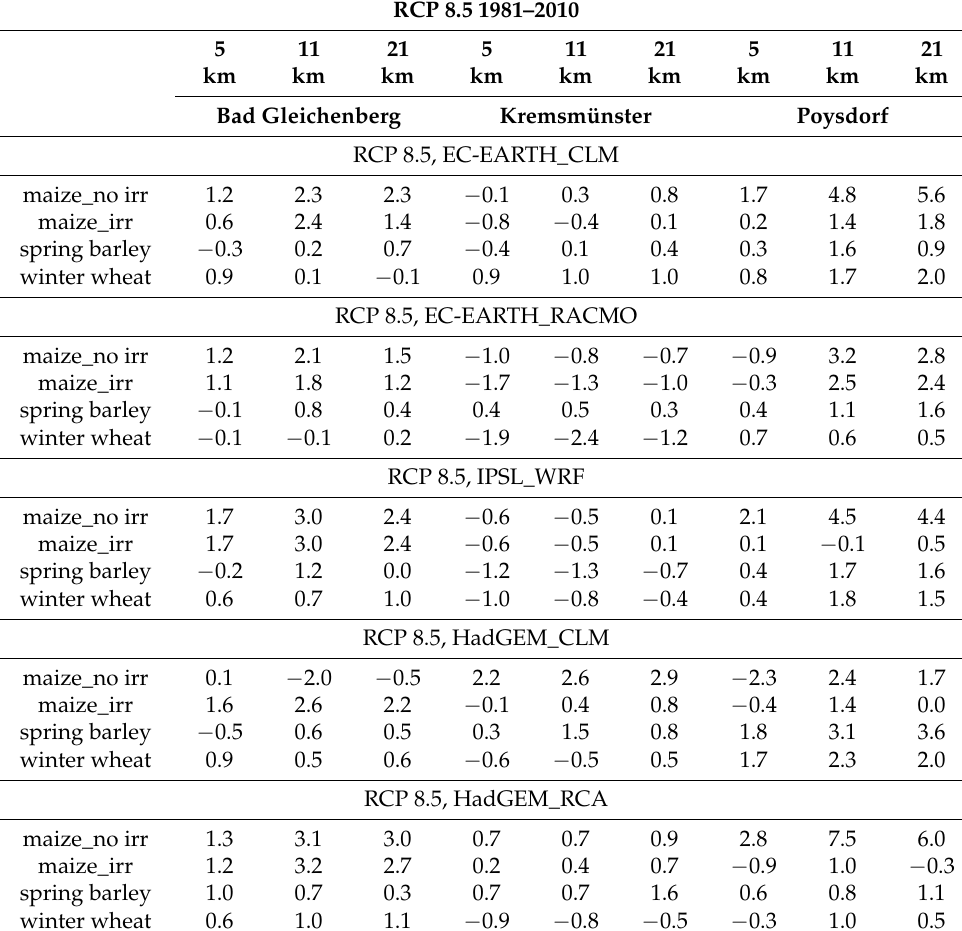
Table 8. Yield differences (%) for maize (rainfed = no irr, optimally irrigated = irr), winter wheat, and spring barley (rainfed) grown on the sandy soil class 1; 1 km input data vs. 5, 11 and 21 km aggre- gated data for five ÖKS15 projections in RCP 8.5 (EC-Earth_CLM, EC-Earth_RACMO, IPSL_WRF, IPSL_RCA and HadGEM_RCA) in Bad Gleichenberg, Kremsmünster and Poysdorf for the 1981–2010 period. Differences in percentages compared with the results with a 1 km resolution. RCP 8.5 1981–2010